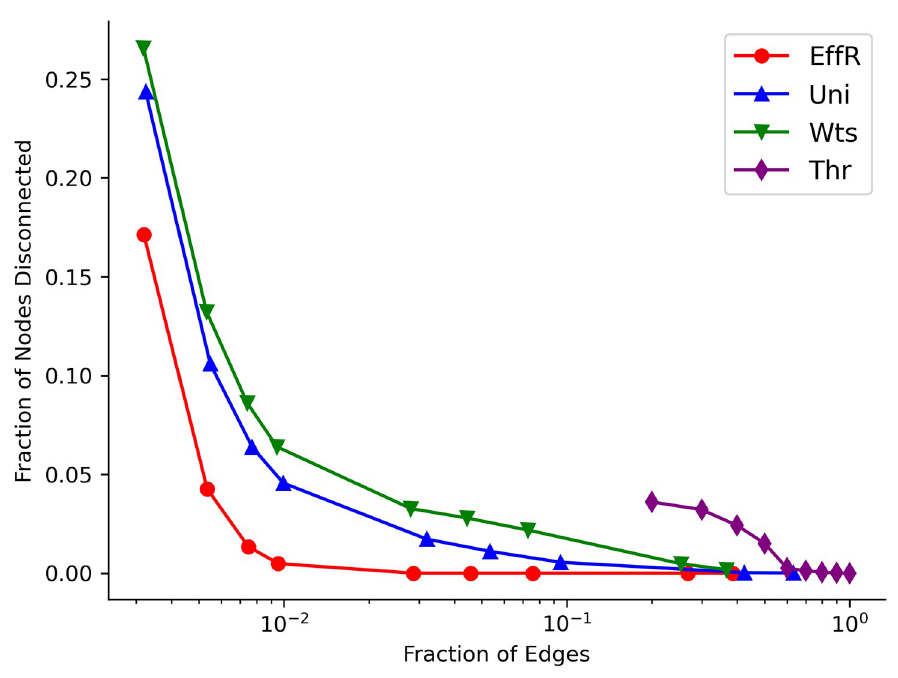
Fig 5. Sparsification of the U.S. mobility network: average fraction of disconnected nodes. The average fraction of nodes disconnected from the largest connected component of the network by sparsifiers of different types. The horizontal axis shows the fraction of edges of the original network preserved by the sparsifier. Even when only 1% of the edges are preserved, effective resistance keeps almost all the nodes connected, while uniform and weight-based sampling disconnects 5% and 7% of the nodes